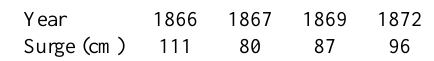
Figure 6. La Rochelle site – systematic and historical data and set- tings of the POTH frequency model. Table 1. Historical known